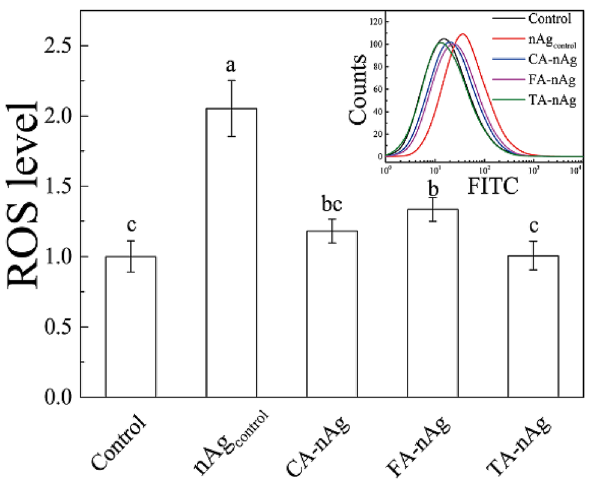
Figure 6. ROS level of A549 cell after incubated with 75 μg ml −1 pristine nAg, CA-nAg, FA-nAg and TA-nAg for 24 h (The significant difference were signed with different letters).